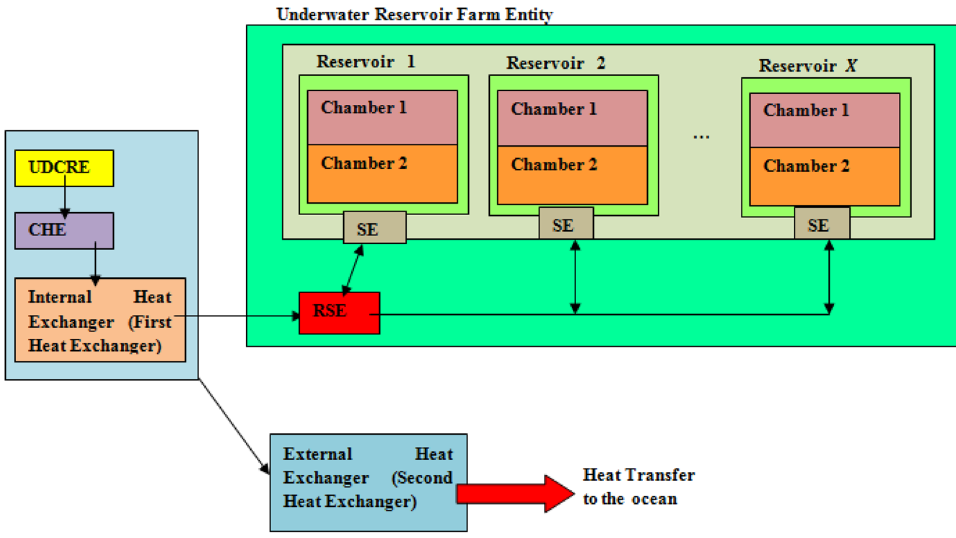
Figure 7. Relations between heat exchangers and reservoir systems in proposed